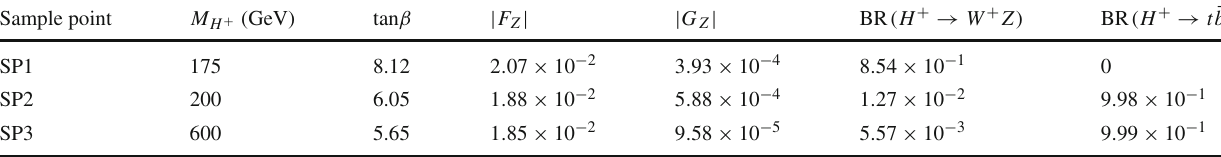
Fig. 13 Variation of branching ratio of H + into different decay modes with tan β for M H + = 200 , 400 , 600 , 800 , 1000 GeV and M S for Type-I and Type-II 2HDM Table 2 Sample parameter points proposed to compute cross sections at pp colliders Sample